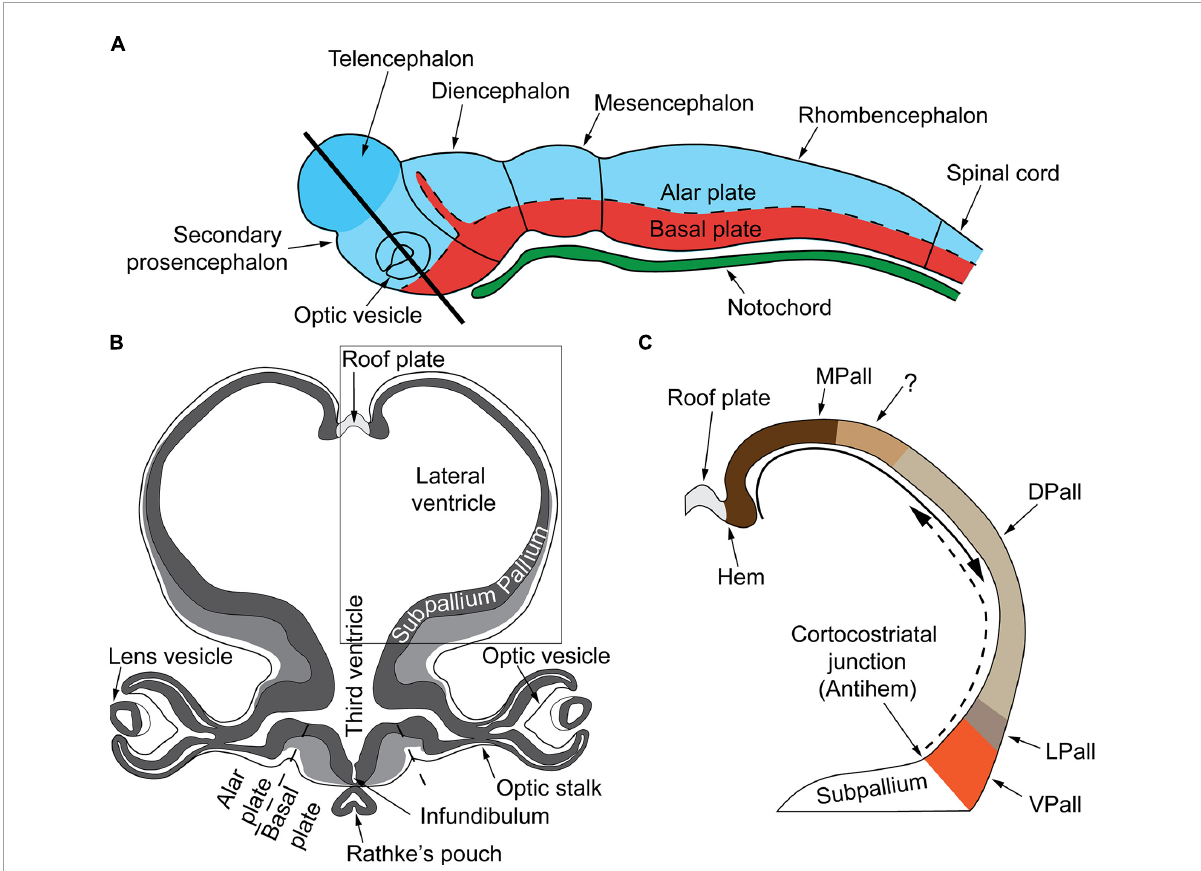
FIGURE2 (A) Very early cerebral cortex development. Sketch of the mammalian neural tube showing the proneuromeric compartments. The neural tube will develop to form the brain and spinal cord. It is divided to the alar plate (colored in blue) that will later generate neurons associated with sensory functions (somatic and visceral), and the basal plate (red) that will primarily contain motor neurons. The notochord, of mesodermal origin (green) provides directional cues to the surrounding tissues. The telencephalic vesicle (highlighted in darker blue) grows out of the alar plate of the secondary prosencephalon. (B) Very early cerebral cortex development. Section through the secondary prosencephalon at the level of the black line in (A) shows the optic vesicles and the telencephalic vesicles; the telencephalic vesicles consist of pallial and subpallial territories. (C) Two organizers direct the patterning of the pallium: the hem, at the border of the roof plate and the prospective hippocampus, and the antihem, at the corticostriatal junction near the prospective olfactory cortex. The morphogen molecules segregated by these organizers form overlapping gradients (solid and dashed arrows) that pattern the pallium in four sectors: medial, dorsal, lateral, and ventral pallial sectors. The distinction of two parts on the MPall sector corresponding to allocortex (hippocampus) and the adjacent mesocortex (marked with “?”) is hypothesized based on architectonic analysis of adult rats and primates. DPall, dorsal pallium; LPall, lateral pallium; MPall, medial pallium; VPall, ventral pallium. Figure from García-Cabezas and Zikopoulos (2019), obtained by Elsevier (No. 5410821023270) under a creative commons license